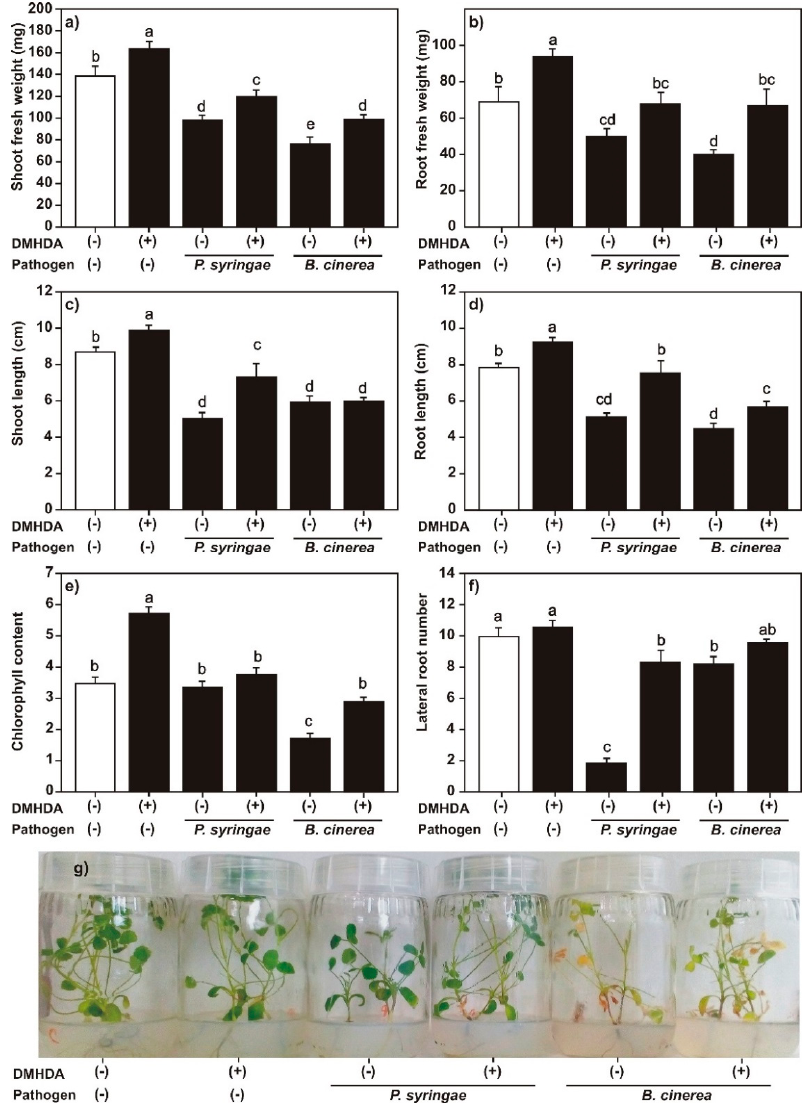
Figure 10. Effect of N,N -dimethylhexadecylamine (DMHDA) on growth of plants of Medicago infected with Pseudomonas syringae or Botrytis cinerea . The M. truncatula plants were cultured in MS medium with DMHDA (8 μ M) and the cultured for 15 days. ( a ) Shoot fresh weight; ( b ) root fresh weight; ( c ) shoot length; ( d ) root length; ( e ) chlorophyll content; and ( f ) lateral root number. Panel ( g ) shows the phenotypes of plants in the treatments. Di ff erent lowercase letters above the standard error bars indicate significant di ff erences calculated with two-way ANOVA and Tukey’s test ( p < 0.5; n =